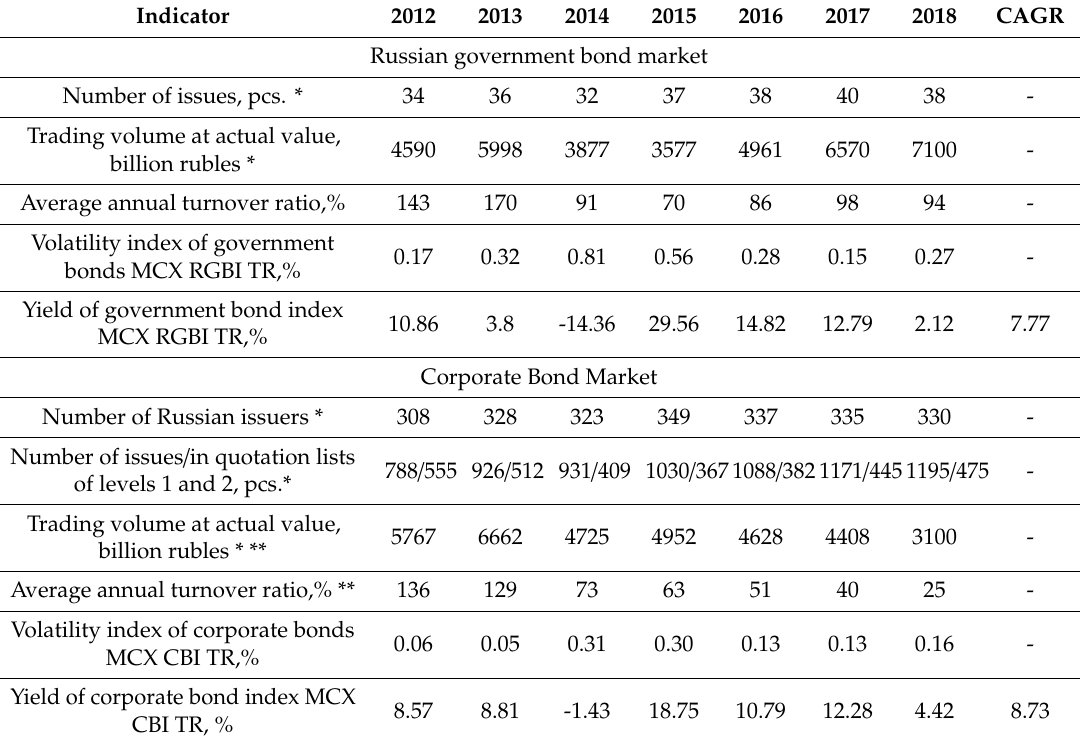
Table 5. Indicators for the Secondary Bond Market of the Moscow